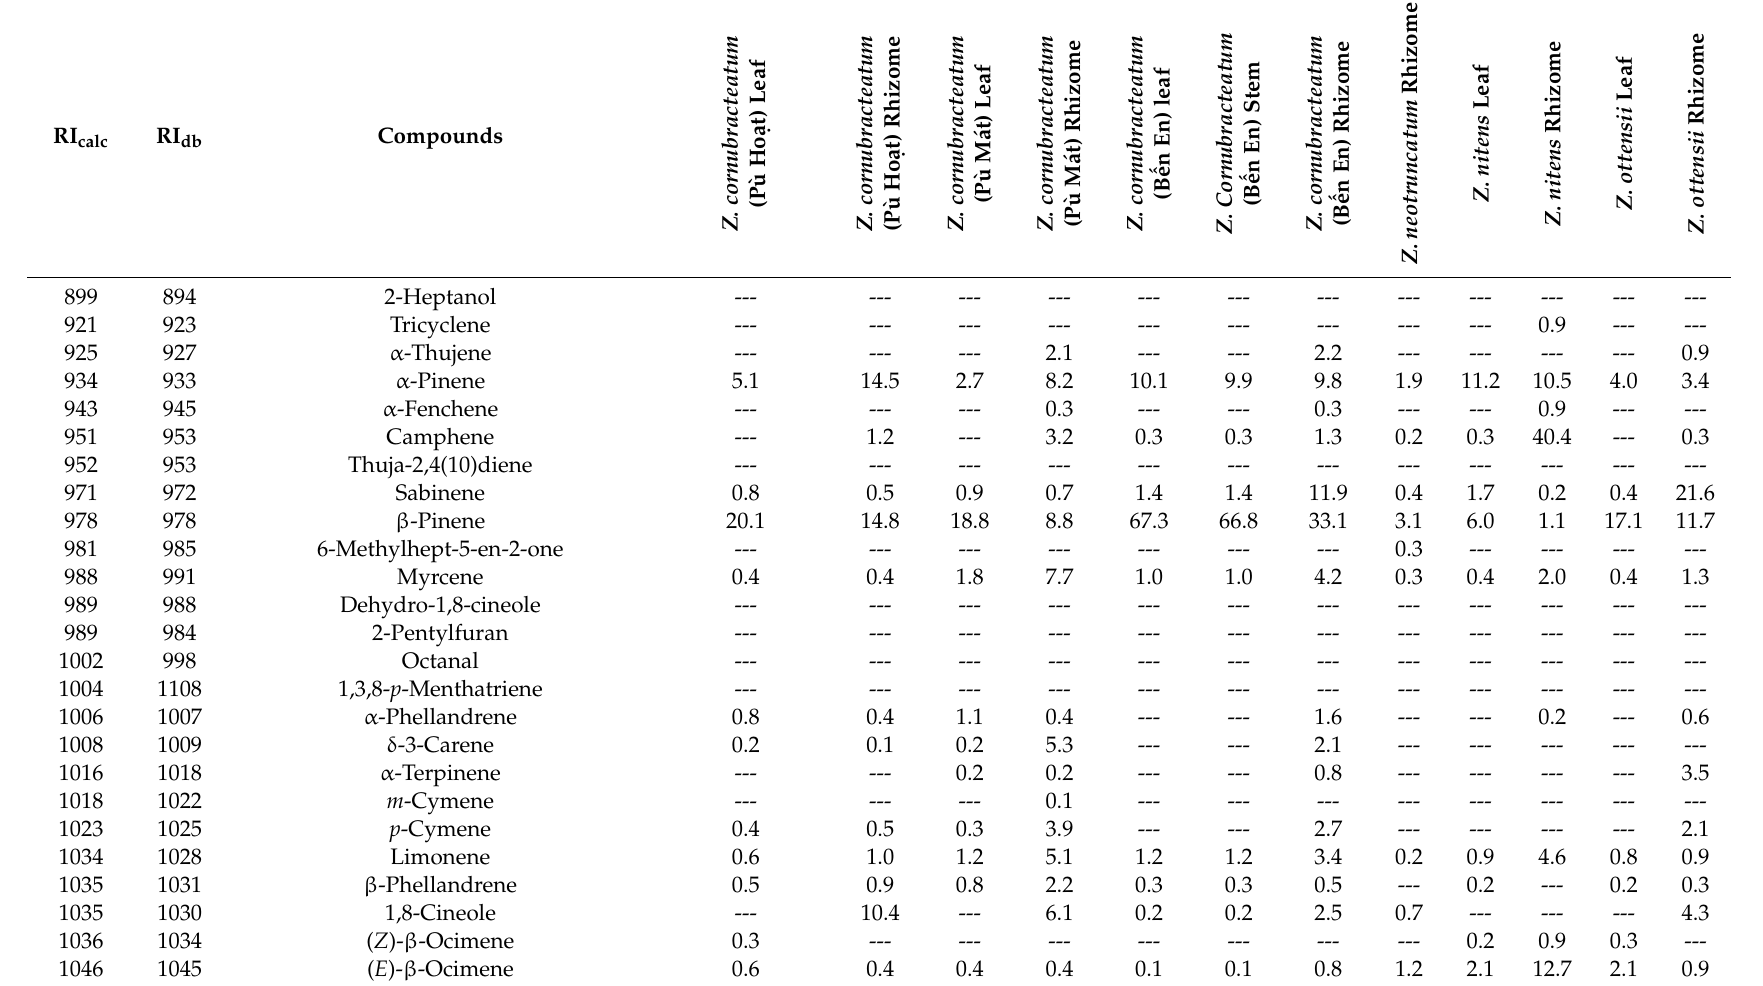
Table 2. Chemical compositions of essential oils of Zingiber species from north-central